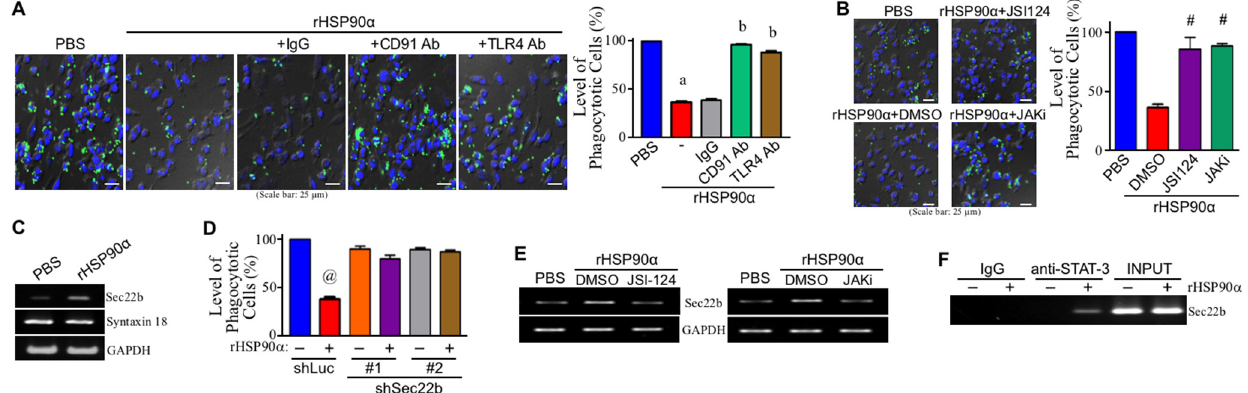
Figure 4. The MyD88–JAK2/TYK2–STAT ‐ 3–Sec22b pathway is involved in the repression of macro ‐ phage phagocytosis by eHSP90 α . ( A ) Phagocytotic activities of the THP ‐ 1 ‐ derived macrophages treated for 24 h with PBS, rHSP90 α , or rHSP90 α plus control IgG or anti ‐ CD91 or TLR4